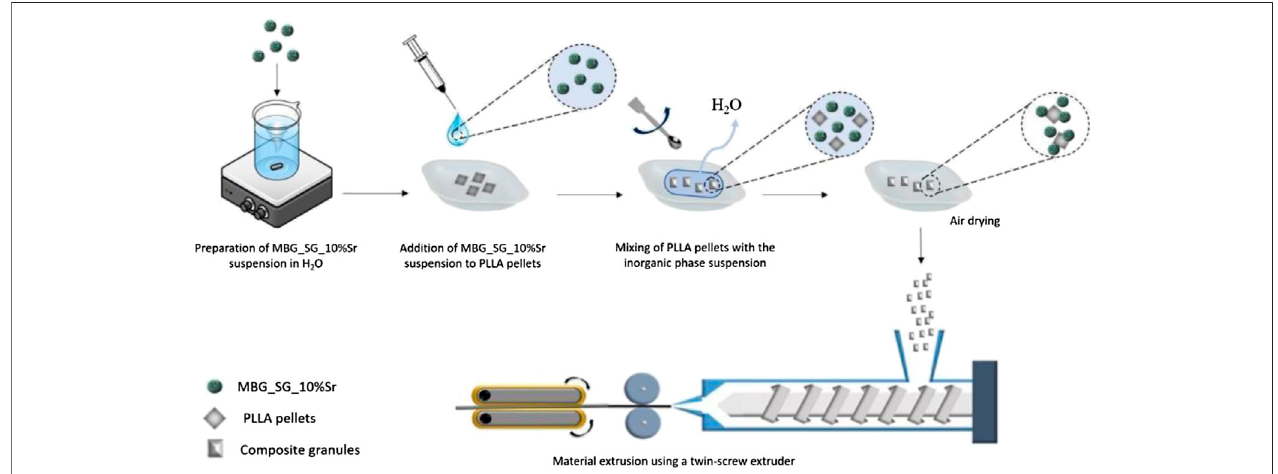
FIGURE1| Schematicrepresentation oftheprocess for theproduction ofcompositefilaments containingMBG_SG_10%Sr(Melo,2019).The same process was used for the fi laments containing HA_50%Sr, except for the preparation of the related suspension (provided by FLUIDINOVA).